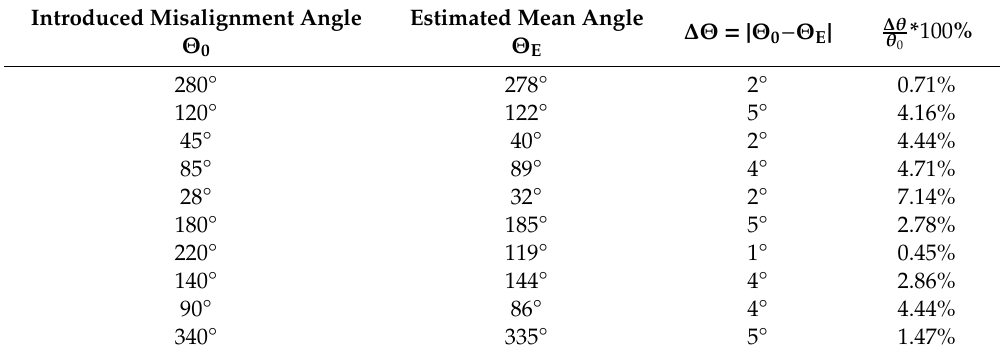
Table 3. The representative analysis of the proposed algorithm accuracy in the determination of the misalignment angles performed for 10 angles and 20 bacterial colonies for ∆ r = 200 µ m.